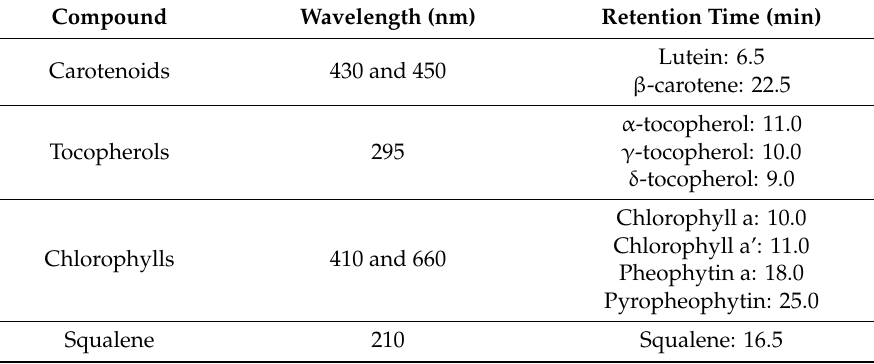
Table 1. Retention times and wavelength of absorption of carotenoids, chlorophylls, tocopherols, and